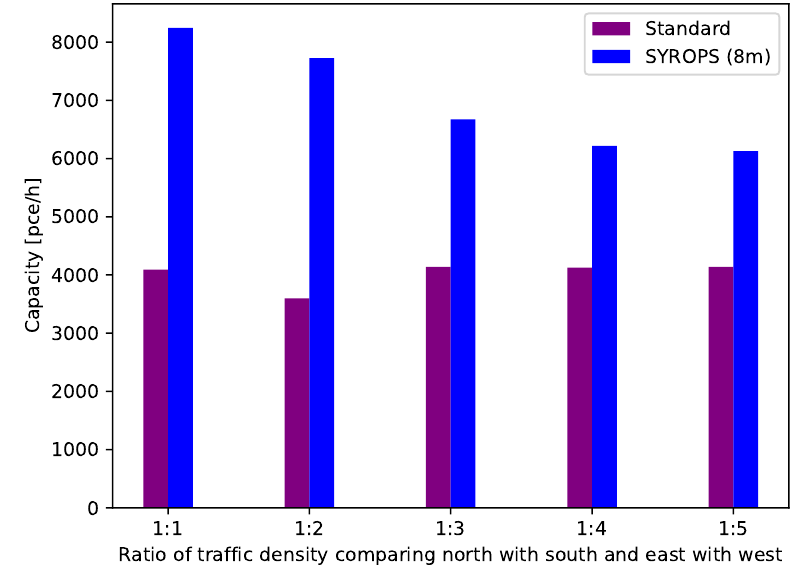
Figure 17. Roundabout capacity in vehicles per hour as a function of traffic unbalance ratio from opposing directions (N vs. S, E vs.